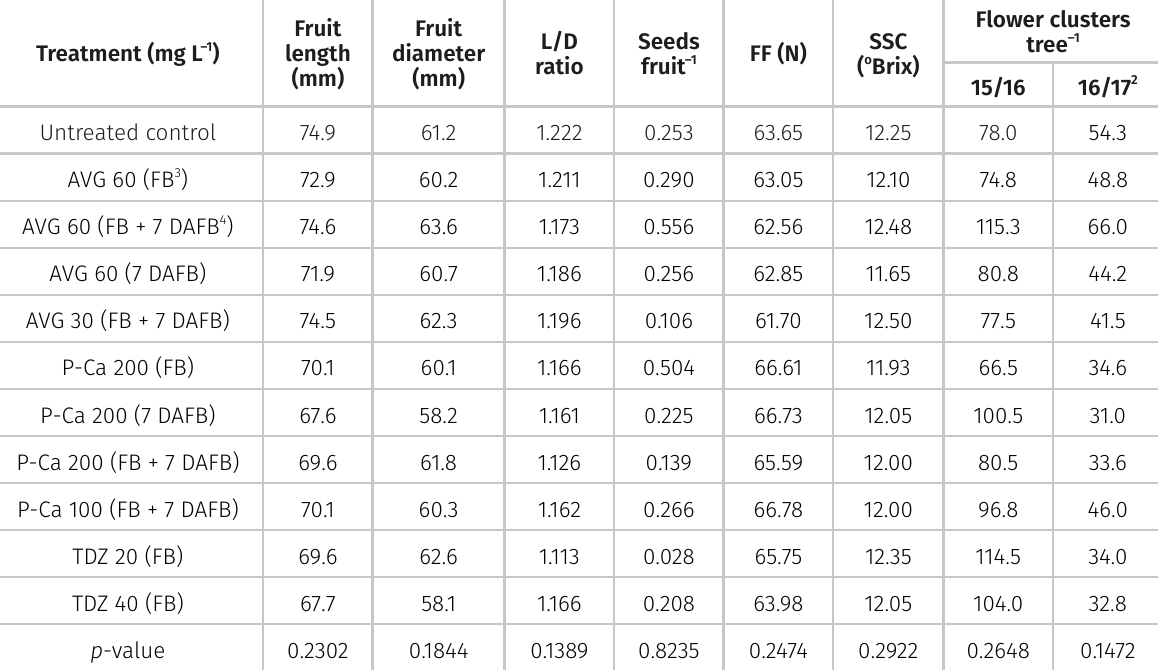
Table II. Fruit length, fruit diameter, fruit length/diameter ratio, number of seed per fruit, flesh firmness (FF), solids soluble contents (SSC) and number of flower clusters on 2015/2016 and 2016/2017 growing season of ‘Rocha’ pear trees treated with different rates and timings of aminoethoxyvinilglycine (AVG), prohexadione calcium (P-Ca) and thidiazuron (TDZ) in São Joaquim, SC, in the 2015/2016 growing